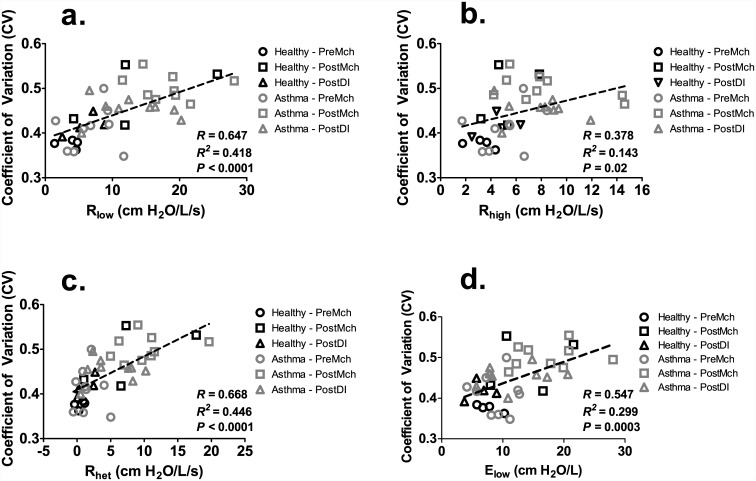
Association between CV and dynamic lung mechanics indices, Rlow (a.), Rhigh (b.), Rhet (c.), and Elow (d.).Note that while there was a significant correlation between CV and Rlow (a.), Rhet (c.), and Elow (d.), there was little correlation seen with Rhigh (b.) over all healthy subjects and mild-to-moderate asthmatics.